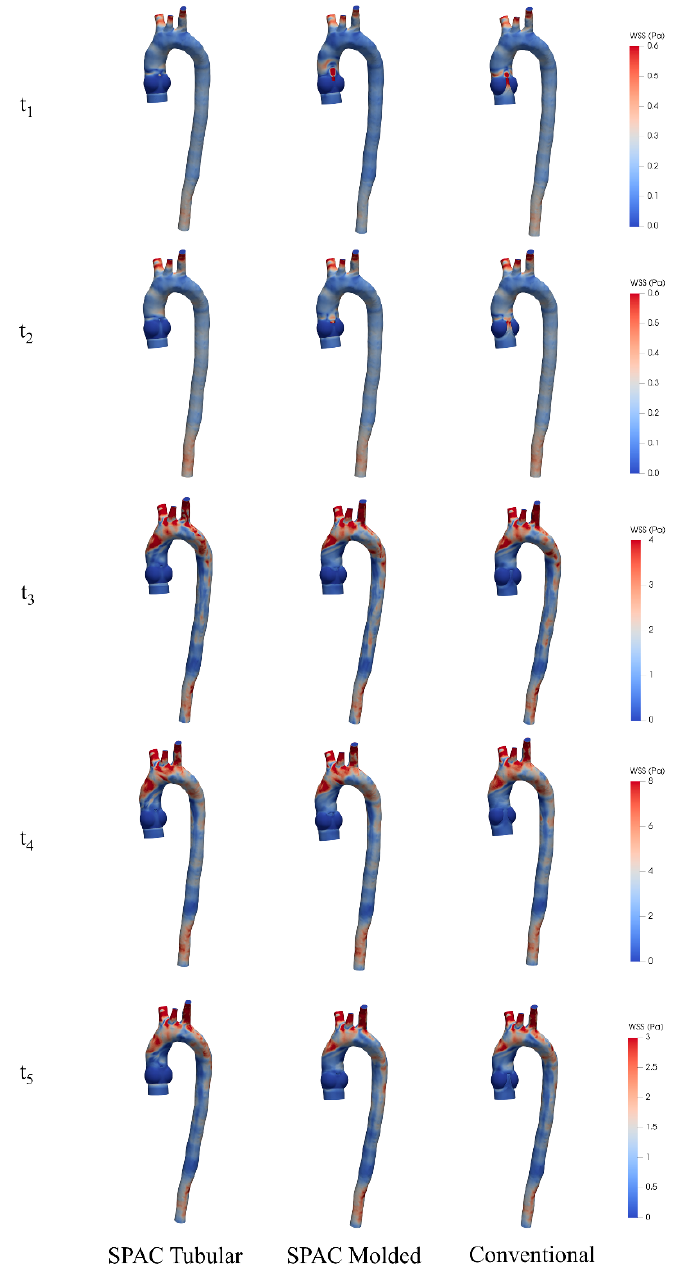
Figure 8. The distributions of wall shear stress (WSS) in three valve models at different time points. The specific values of SAWSS and low WSS areas on the entire aorta are listed in Table 3.